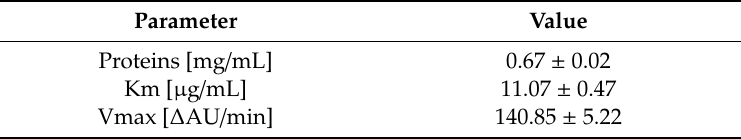
Table 3. IC 50 [µM] value of polyphenols showing inhibitory effect on TPO activity used in the study, n = 9.